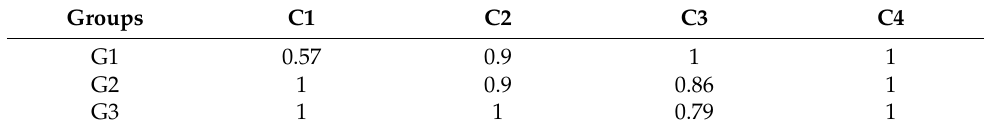
Table 14. Level of maximum clustering coefficients by criteria for each group.